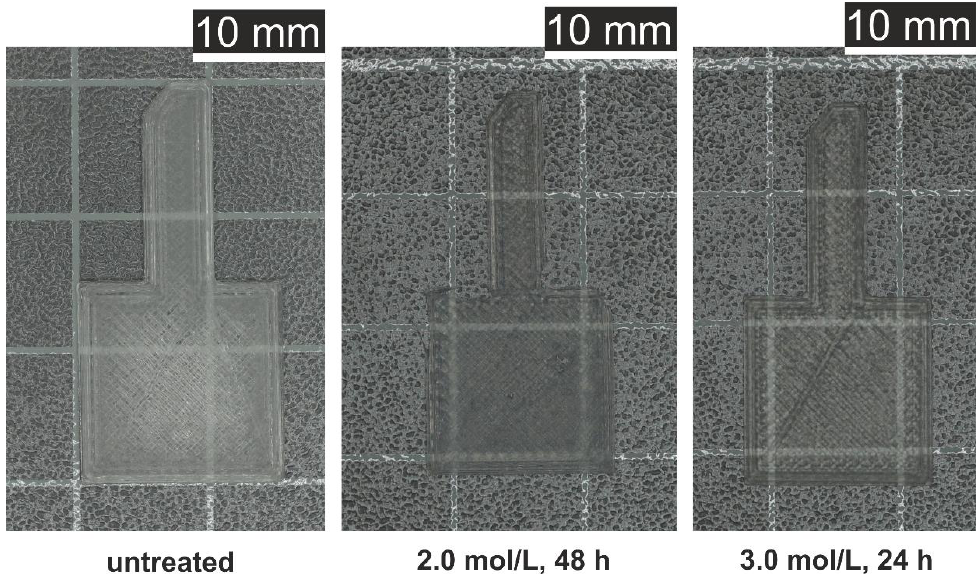
Figure A5. PLA surface of different samples.